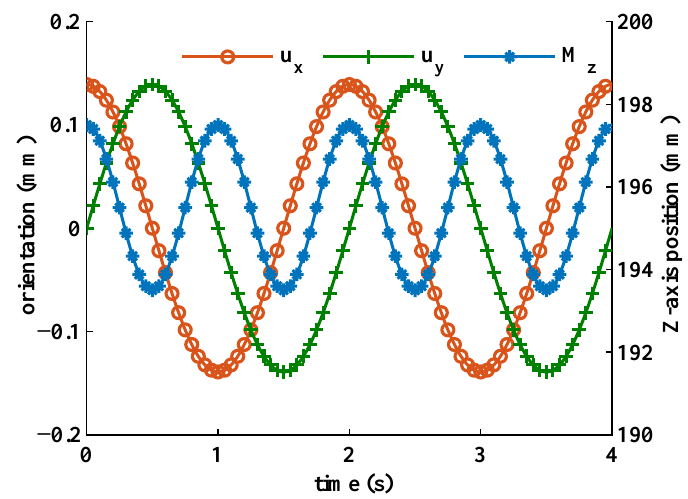
Figure 6. Desired motion for the moving platform of the 2R1T 3PPS PKM.